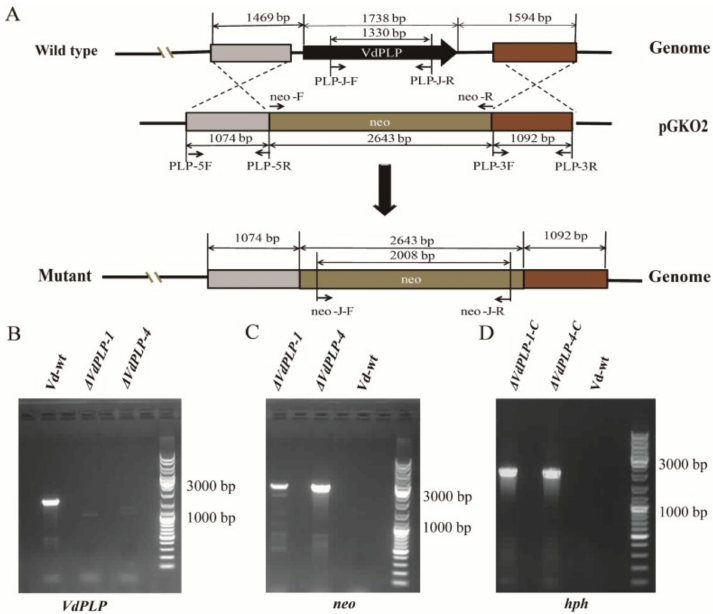
Figure 1. VdPLP gene disruption in V. dahliae and complementation of the ∆ VdPLP strains ( ∆ VdPLP-1 and ∆ VdPLP-4 ). ( A ) Disruption scheme used for VdPLP in the wild type (wt) strain (Vd-wt); gene disruption was confirmed by PCR. Genomic DNA (gDNA) from the Vd-wt, ∆ VdPLP and ∆ VdPLP-C strains were used as templates for amplification with primer pairs VdPLP-J-F/VdPLP-J-R, neo-J-F/neo-J-R and hyg-F/hyg-R; ( B ) A 1.3-kb fragment of VdPLP was amplified from Vd-wt with primer pair VdPLP-J-F/VdPLP-J-R; ( C ) A 2.6 kb fragment of neo was amplified with primer pair neo-J-F/neo-J-R from the ∆ VdPLP mutant strains; ( D ) Gene complementation of the ∆ VdPLP strains ( ∆ VdPLP-1-C and ∆ VdPLP-4-C ) was confirmed by amplification of a 1.6 kb fragment of hygromycin B resistance gene ( hph) in PCR with primer pair